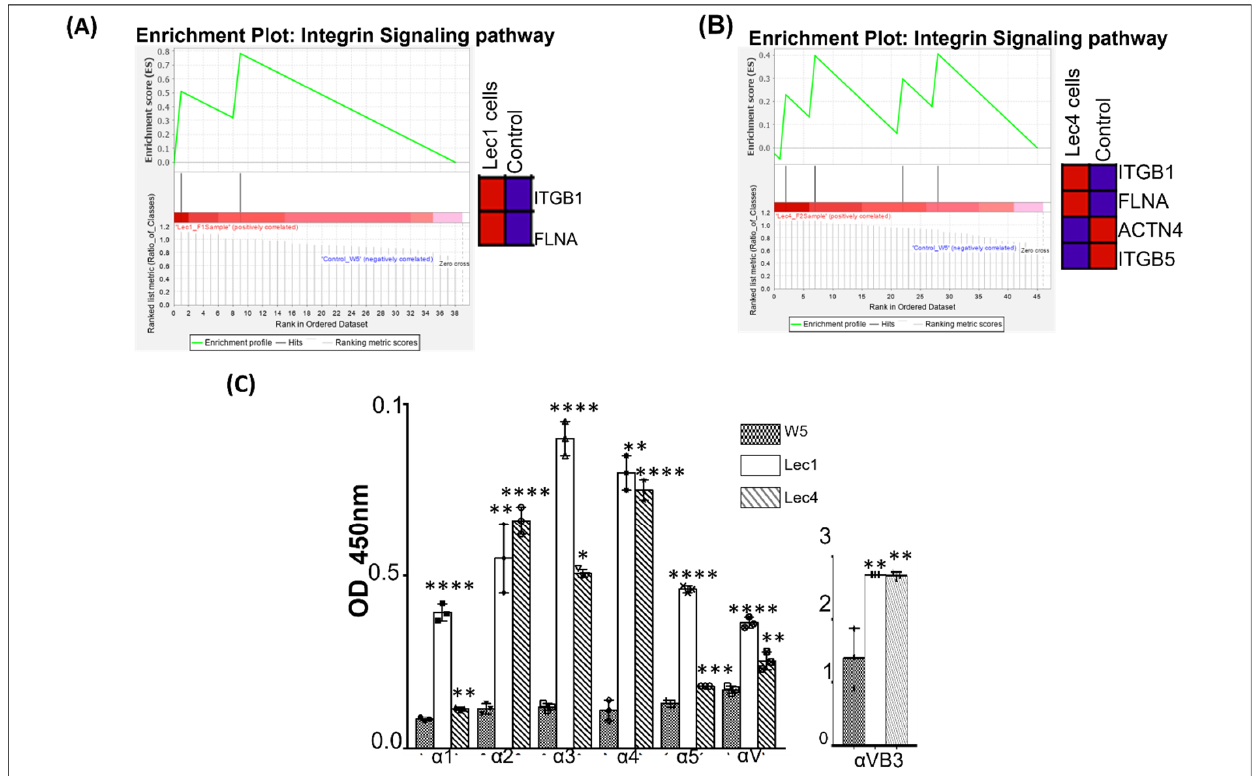
Figure 6. Analysis of cell surface integrins for differentially expressed proteins in Lec1 and Lec4 cells via GSEA analysis and ELISA assay. GSEA enrichment plots of gene clusters that were enriched in ( A ) Lec1 and ( B ) Lec4 cells in the integrin signaling pathway. Heat map shows the genes that regulate this pathway; red color indicates upregulation and blue color indicates downregulation. ( C ) Binding assay for integrins ( α 1, α 2, α 3, α 4, α 5, α v β 3) in control (W5), Lec1, and Lec4 cells detected by ELISA assay. The cells were co-incubated with the corresponding integrins in the ELISA-coated microwell plates and integrin binding to the cell surface was detected. Cell attachment was analyzed by obtaining optical density at 450nm. Negative control was done without coated antibody to calculate the amount of integrins expressed in each cell type (W5, Lec1, and Lec4). Data are shown as means S.D. of triplicate experiments. * p value < 0.05, ** p value < 0.01, *** p value < 0.001 and **** p value < 0.0001.